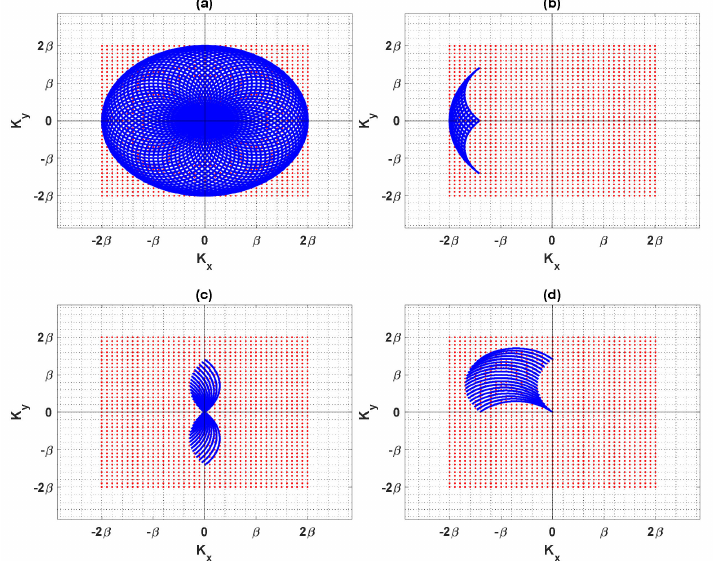
Figure 2. The domain of object function in the spectral domain: ( a ) full-view, ( b ) receiving mode, ( c ) transmission mode, ( d ) angle